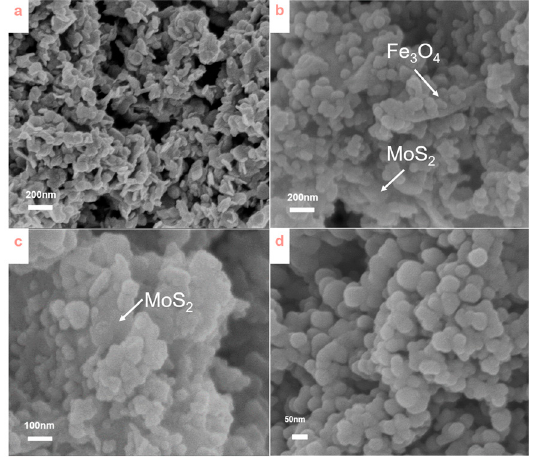
Figure 3. SEM images of ( a ) MNs, ( b ) MFN, ( c ) MFNNs, and ( d ) bare nZVI.